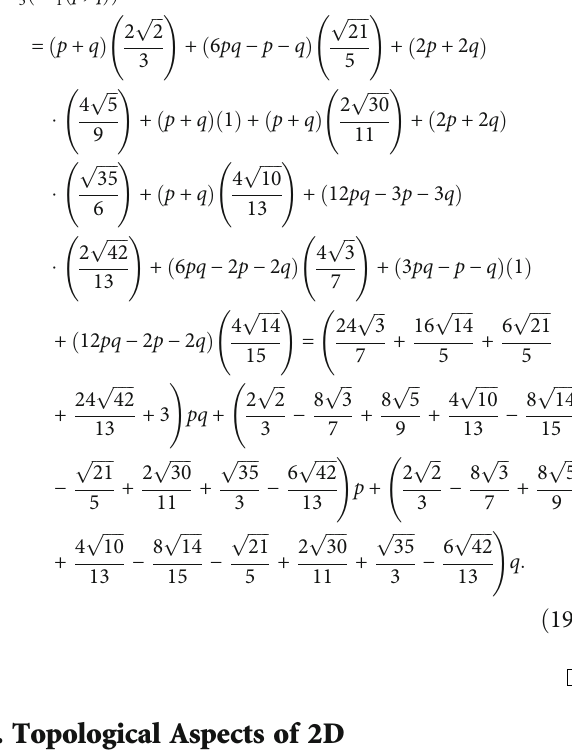
p , q Þ based on the sum of degree 1 ð